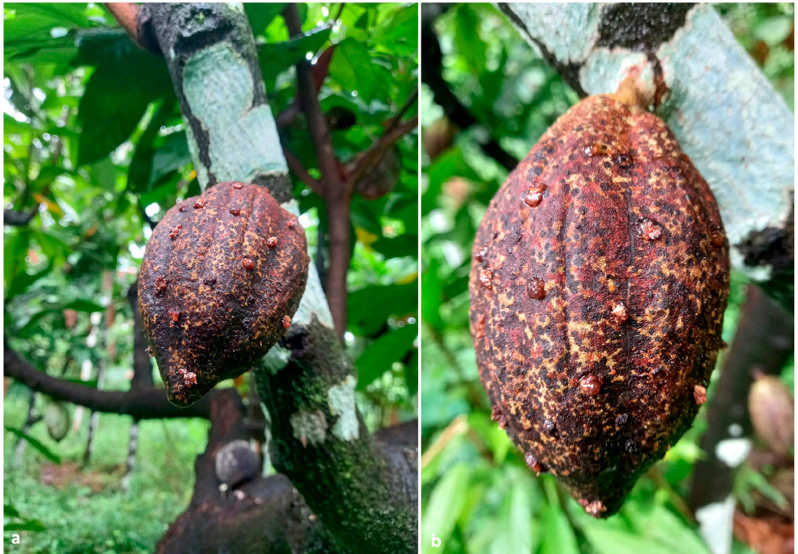
Figure 3. ( a ) Cocoa pod exhibiting oozing of brownish sap and frass; ( b ) detailed view of the attacked pod showing the scattered distribution of the boring points of the scolytine beetles.